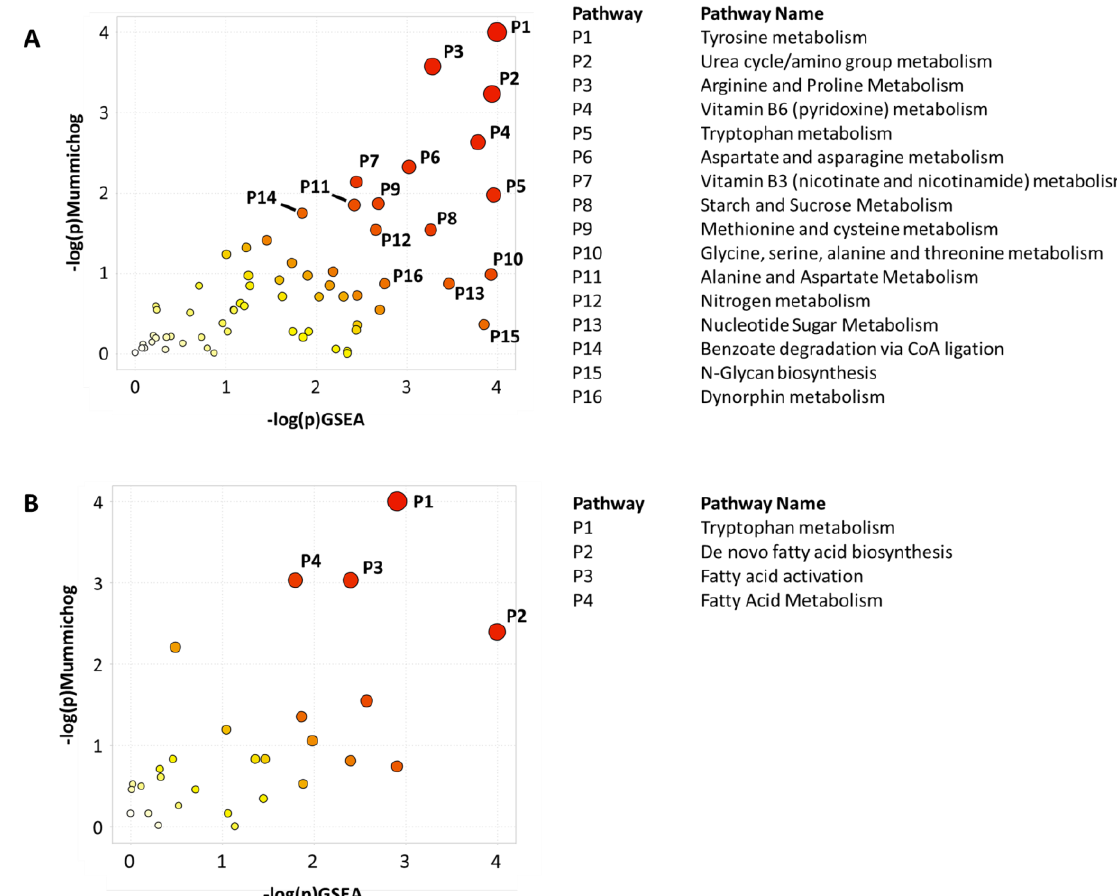
Figure 3. Metabolic pathways impacted by sample preparation methods. Pathway analysis was performed between ( A ) trypsinized vs scraped samples, and ( B ) freeze–thaw vs. homogenizer bead samples using MetaboAnalyst. Both the mummichog and GSEA algorithms were performed to determine the enriched pathways. Pathways with an integrated p -value less than 0.05 are annotated. Pathways are numbered in order of increasing integrated p -value.